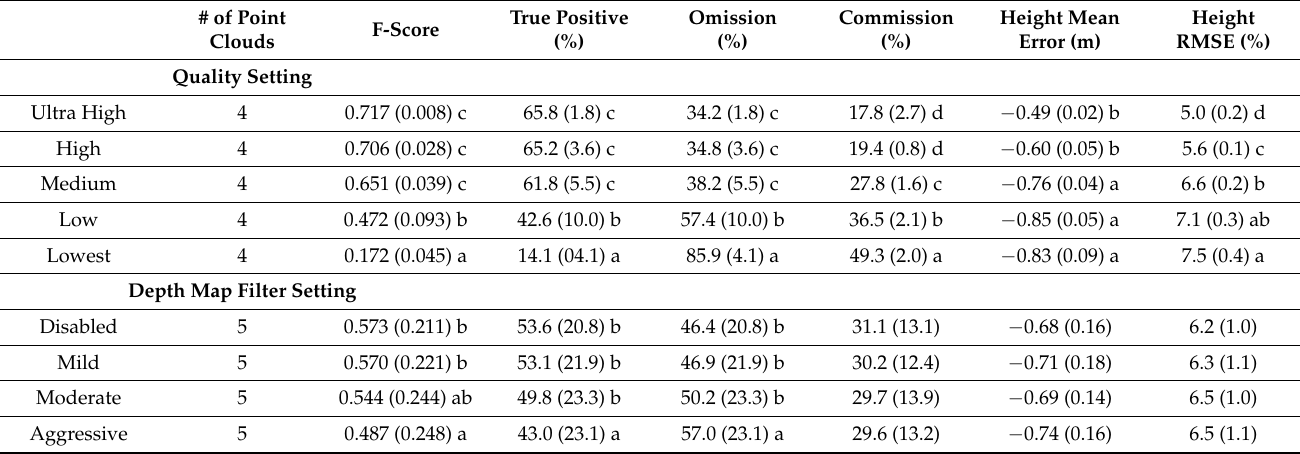
Figure 3. Subsets of filtered UAS-SfM point cloud-derived canopy height models (CHMs) (13 m × 30 m) for the 20 combinations of the build dense cloud Quality and depth map filter parameter settings. UAS-derived orthophoto of the subset area provided to aid in CHM inspection. Table 3. Influence of Metashape build dense cloud Quality and depth map filter settings on the mean (standard deviation) of overstory tree F-score and true positive, omission, and commission rates. Letters represent significant differences ( α = 0.05) determined by two-way ANOVA with Tukey’s HSD